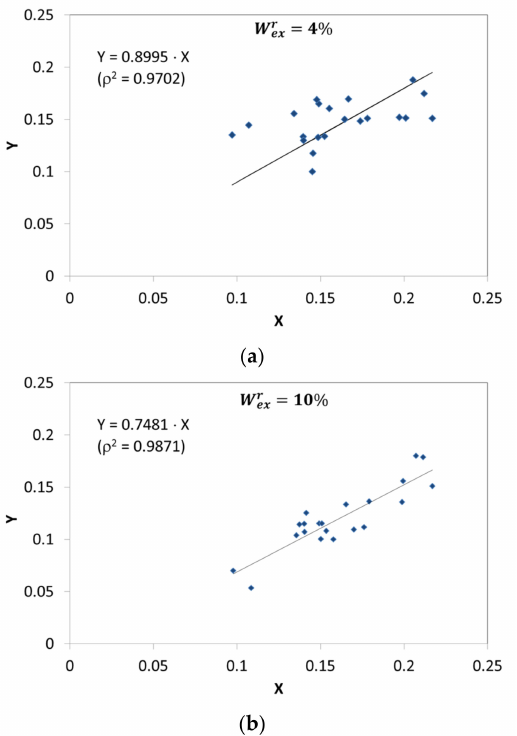
Figure 9. Triangle grains for grain distributions close to the maximum density and for two levels of moisture content recalculated into air-drying basis: ( a ) 4%, ( b )